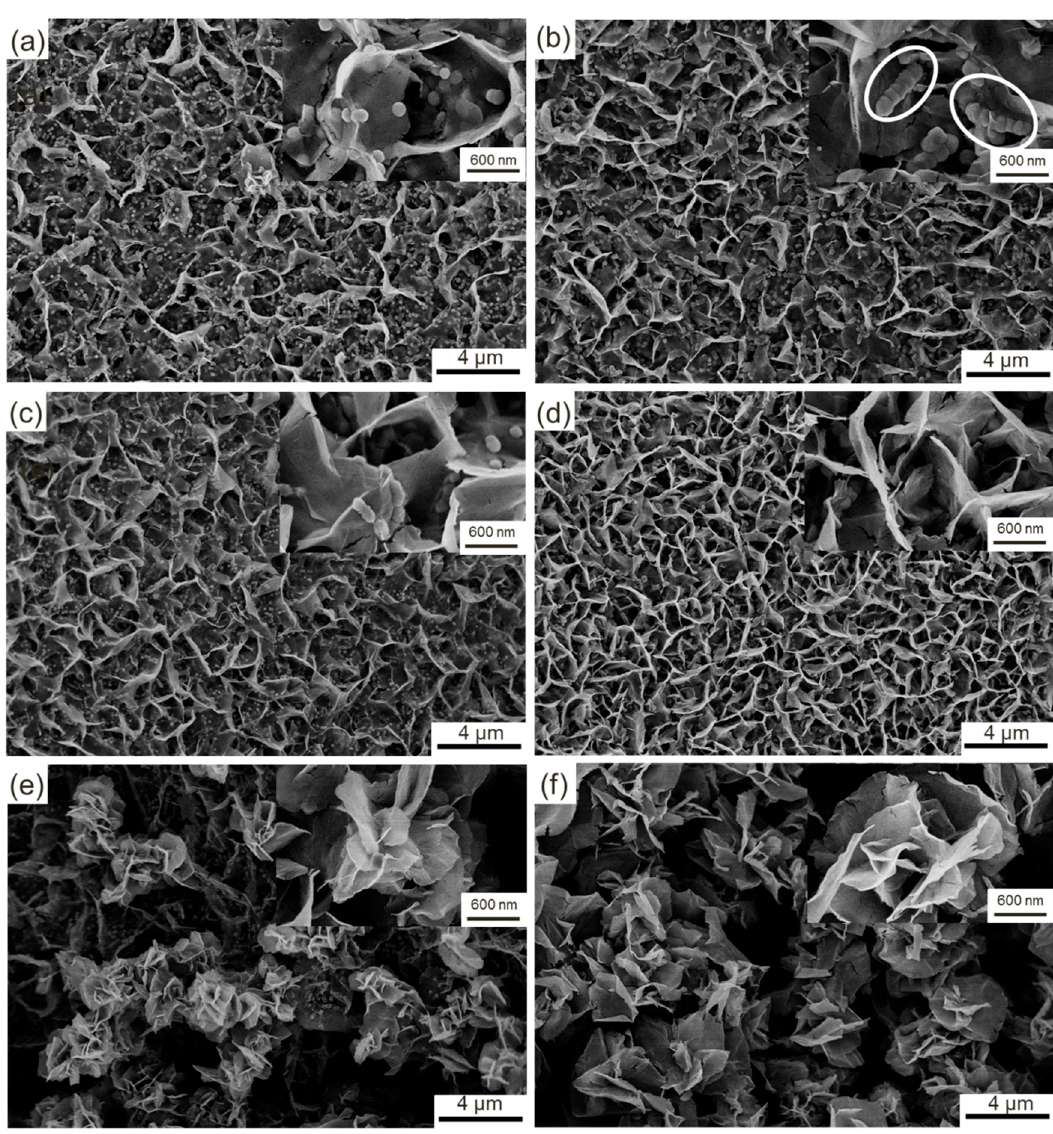
Figure 10. SEM images of the samples: ( a ) Sample A; ( b ) Sample B; ( c ) Sample C; ( d ) Sample D; ( e ) Sample E; ( f ) Sample F.